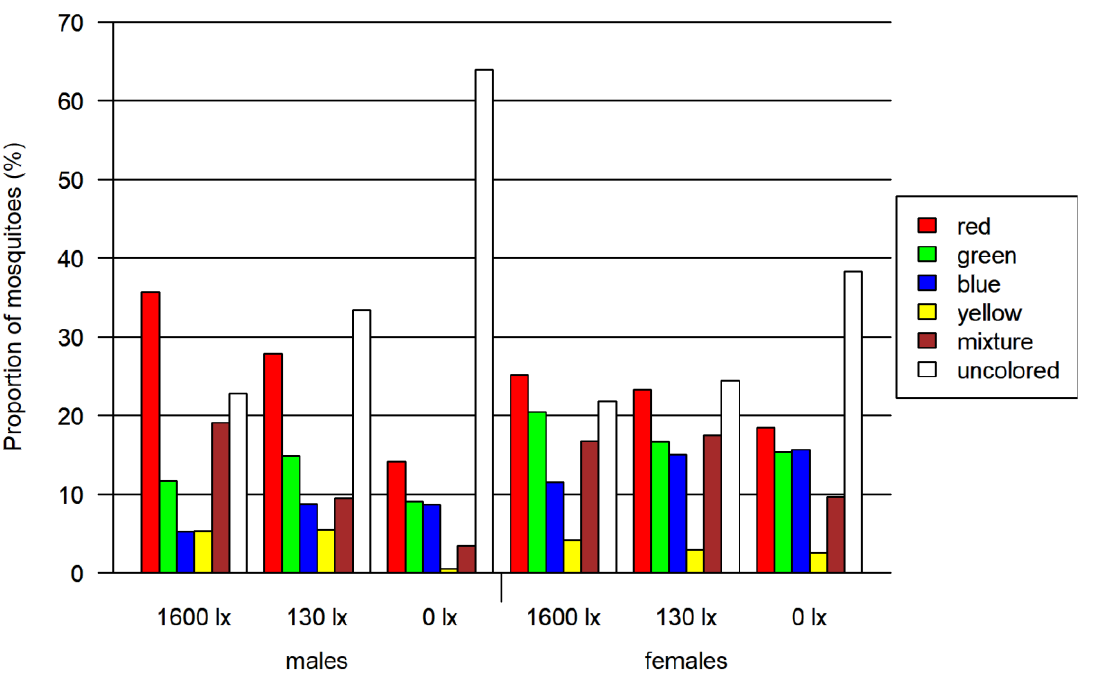
Figure 4. Results of the four-choice feeding bioassay. Left: results for females and males. Right: results only for females. Both tested at three light intensities. The 1600 lx light intensity was the maximum light intensity during a 16:8 h light cycle (Light:Dark; separated by one hour crepuscular periods; daylight at 1600 lx), while the 130 lx and the 0 lx bioassay were at constant light intensity. The proportion of mosquitoes is normalized by setting of lux.